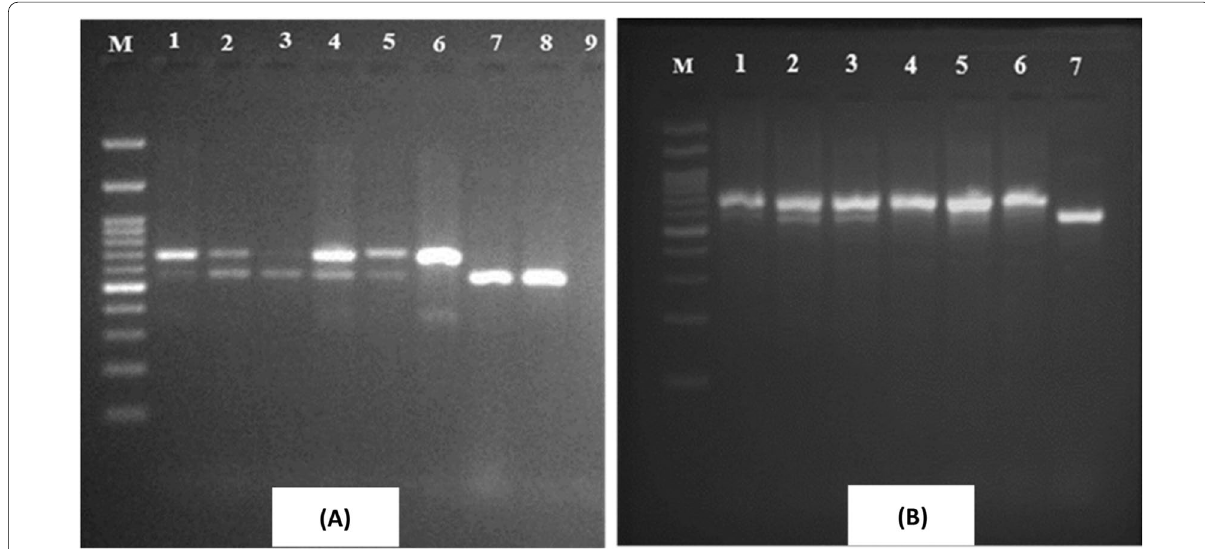
Fig. 4 Confirmation of endophytic colonization of Beauveria bassiana UHSB-END1 through PCR using endophyte-specific ITS primers. a M-ladder, Lanes 1–14, 2–40, 3–60, 4–80, 5–120 dpi, 6-Control, 7—mother culture (original fungal strain), 8—reisolated fungus, 9—negative control (without DNA template); b M-ladder, Lanes 1—fresh seeds, 2–10-day dried seeds, 3–25-day-old seedlings, 4—control (fresh seeds),5—control (10-day dried seeds), 6—control (25-day-old seedlings), 7—mother culture (original fungal strain)